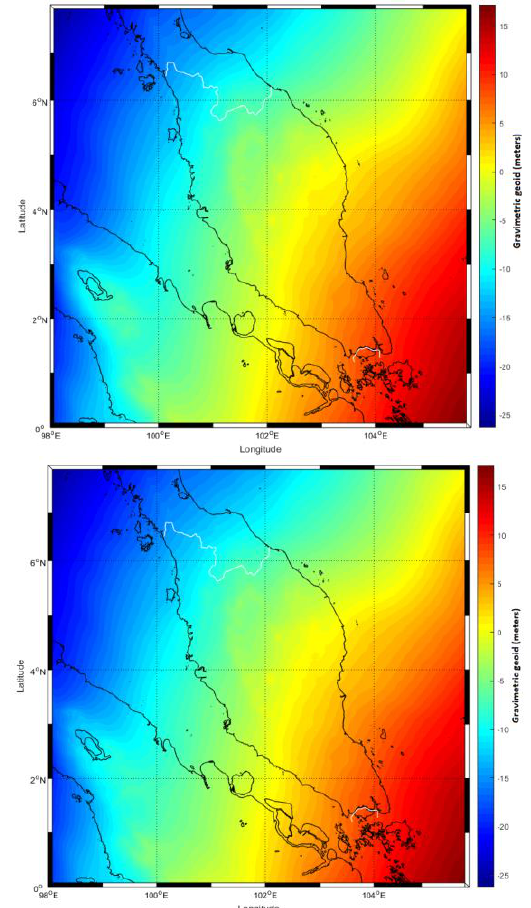
Figure 9 Final gravimetric geoid from (a) Strategy 1, (b) Strategy 2 and (c) difference between the two geoid at land region